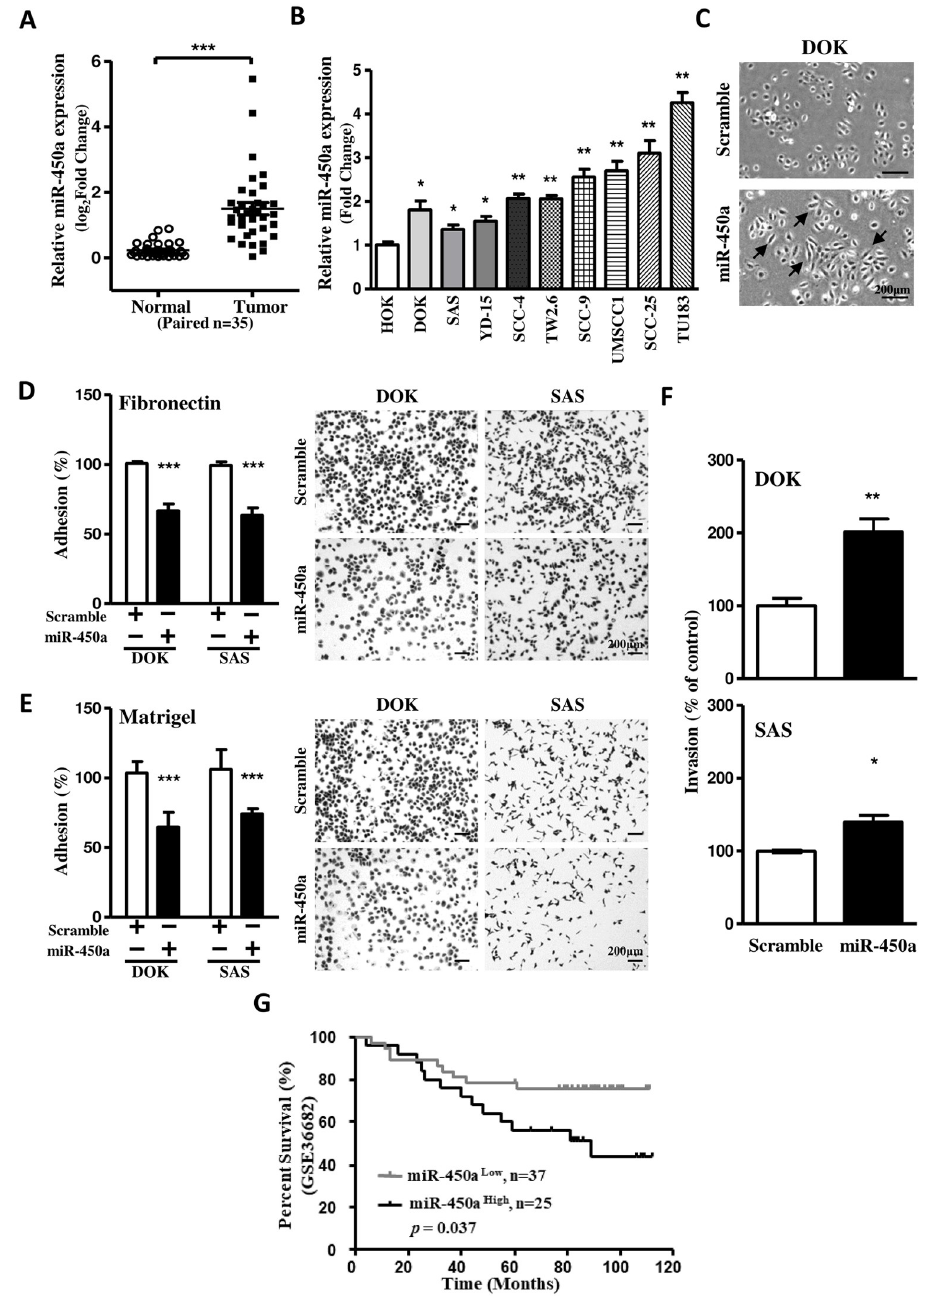
Fig 1. Up-regulated miR-450a impairs cell adhesion and enhances invasion of OSCC. (A-B) The expression levels of miR-450a in human OSCC clinical specimens (n = 35) and human OSCC cell lines (n = 9) were measured and normalized to RNU44. (C) Presentative DOK morphology changes under the transfection of miR-450a mimic and control (scramble). Arrowhead indicates that a morphological change from a rounded shape into a spindle-like shape. (D-E) Cell adhesion assay in DOK and SAS cells transfected with miR-450a mimic and scramble control on fibronectin and matrigel were stained and quantified as described in methods. Bars in the right lower corners of all photos are equivalent to 200 μ m. (F) Transwell invasion assays were used to measure the effect of miR-450a in DOK and SAS cells after 48 hrs transfection. (G) Kaplan-Meier survival plot for miR-450a expression in HNSCC patients. The survival curves were analyzed in GSE36682 cohort (n = 62). Presentative images were performed from at least three independent experiments. Data was represented as mean ± SEM; �� P < 0.01; ��� P < 0.001.